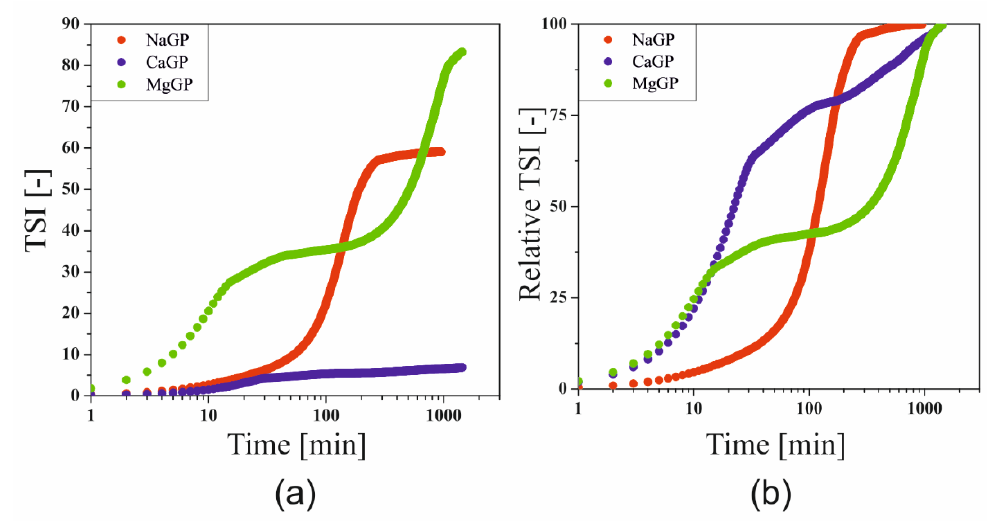
Figure 7. Influence of the type of glycerophosphate salt on the change in the value of the ( a ) desta- bilization and ( b ) relative destabilization parameters.